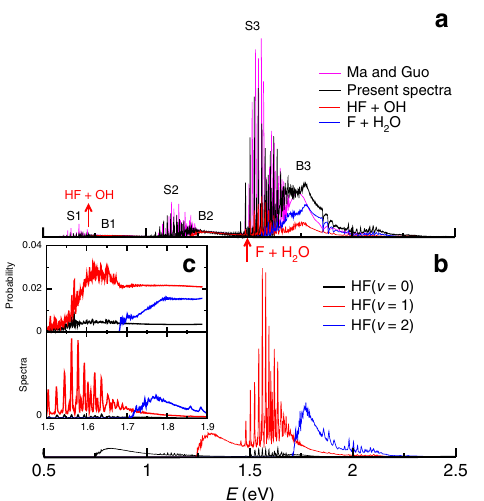
Fig. 4 Photoelectron spectra of the FH 2 O − system. a Theoretical photoelectron spectra and reactive fl ux spectra of the FH2O − anion on the present neural network potential energy suface, in comparison with the spectra of Ma and Guo28. E is relative to the minimum energy of the neutral PES, i.e., the static energy of the bottom of the product hydrogen bond well. The red arrows indicate the zero-point energy of the HF + OH asymptote (0.718 eV) and F + H 2 O (1.488 eV) asymptote, respectively. b The HF vibrational state-resolved reactive fl ux spectra to HF + OH. c The comparison between the HF vibrational state-resolved reaction probabilities of the neutral reaction and the reactive fl ux spectra at the energy of 1.5 – 1.9